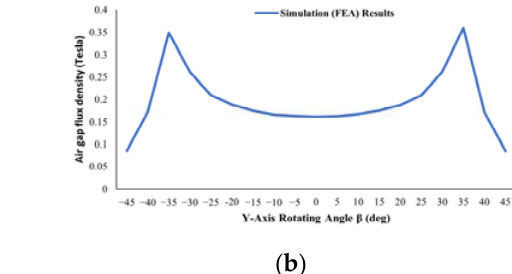
Figure 9. Magnetic field distributions of the motor at loaded conditions rotating around the Y ‐ axis: ( a ) view of the motor that is at β = 0°; ( b ) view of the motor that is at β = +45°; ( c ) view of the motor that is at β = –45°.